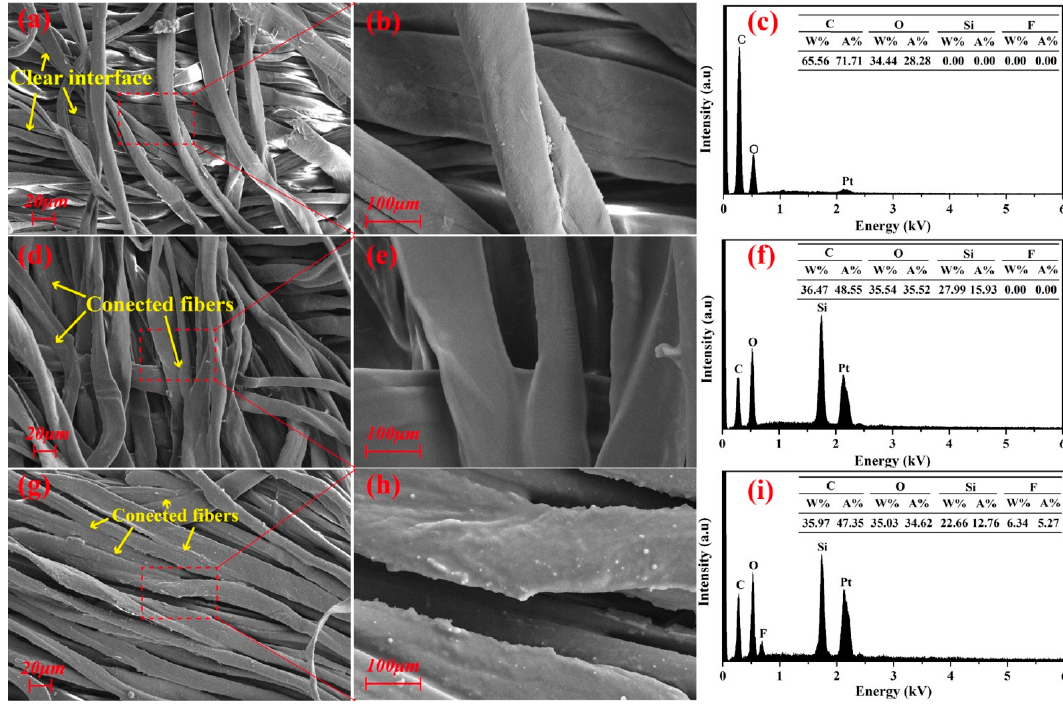
Figure 3. SEM images of pristine ( a,b ), PMHS-modified ( d,e ), and fluorinated olefin-modified ( g,h ) cotton fabrics and corresponding EDX (energy-dispersive X-ray spectroscopy) spectra ( c,f,i ).